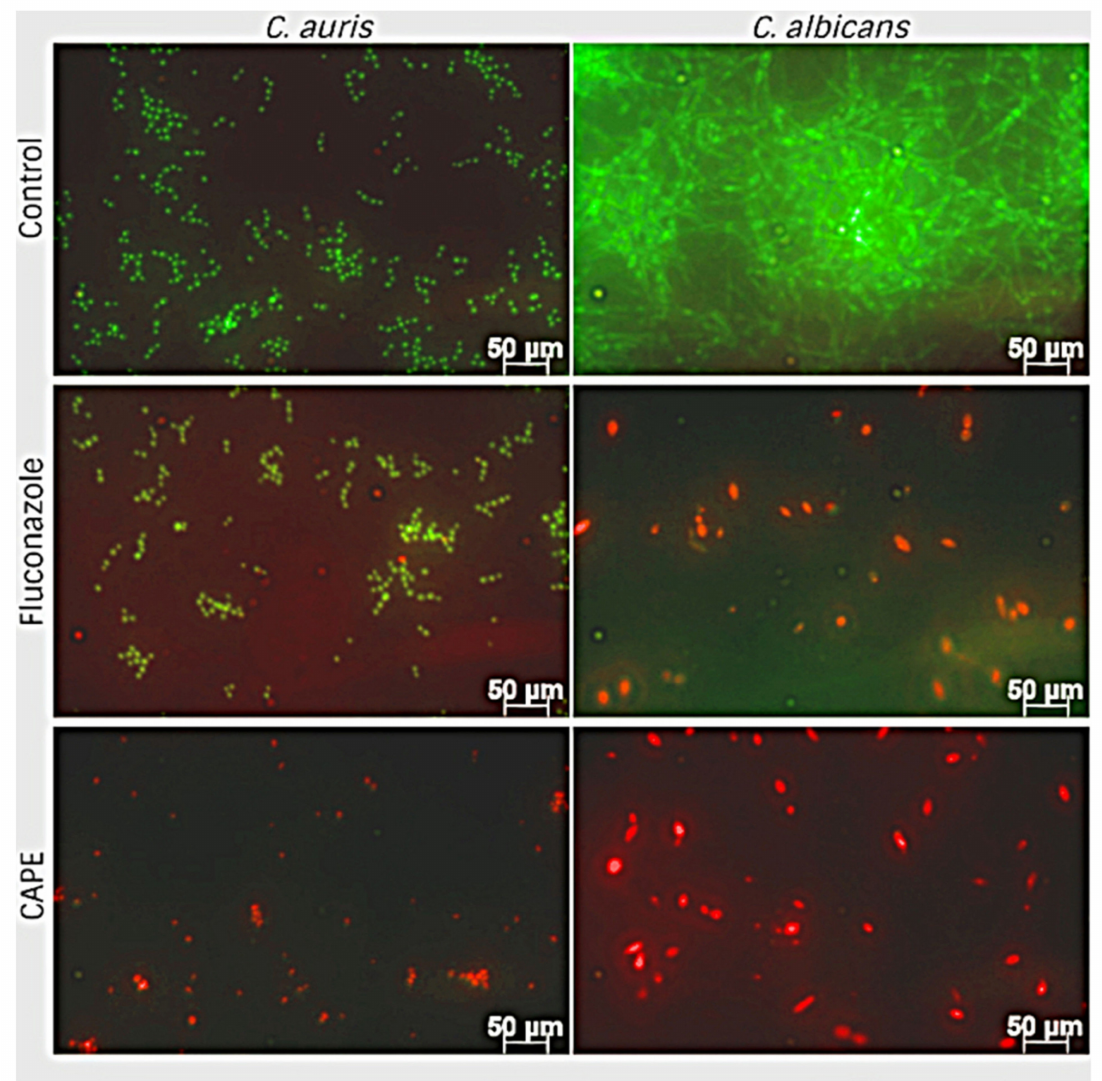
Figure 4. Fluorescence microscopy comparison of C. auris and C. albicans biofilms grown in the presence of CAPE and fluconazole. Images taken in two different channels (red and green) were overlapped. C. auris and C. albicans biofilms were treated with CAPE 2 × MIC (32 µ g/mL and 16 µ g/mL, respectively) and fluconazole (32 µ g/mL and 16 µ g/mL,